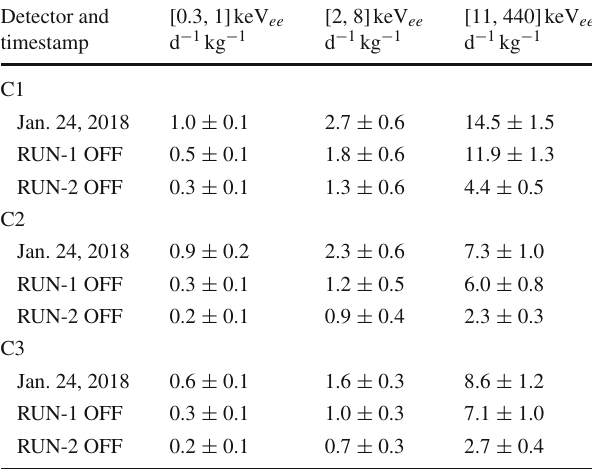
Table 7 Rate contribution of the decay of the cosmogenic isotopes within various energy ranges during different time periods, as evaluated from the MC Detector